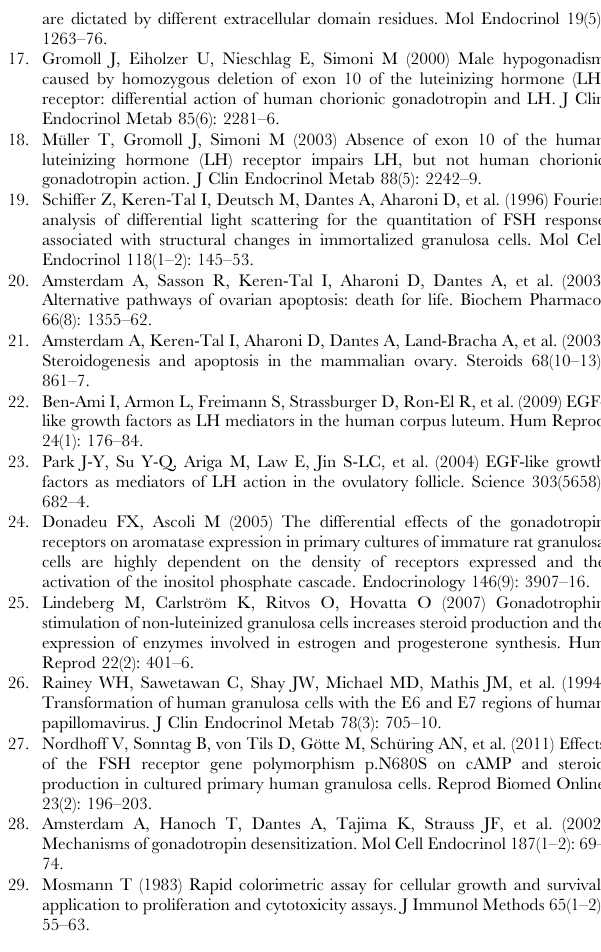
Figure S7 Western blot analysis of phospho ERK1/2 ( a ) and phospho AKT ( b ) and efficacy of the relative inhibitors U0126 and LY294002 in hGLC stimulated for 15 with hLH or